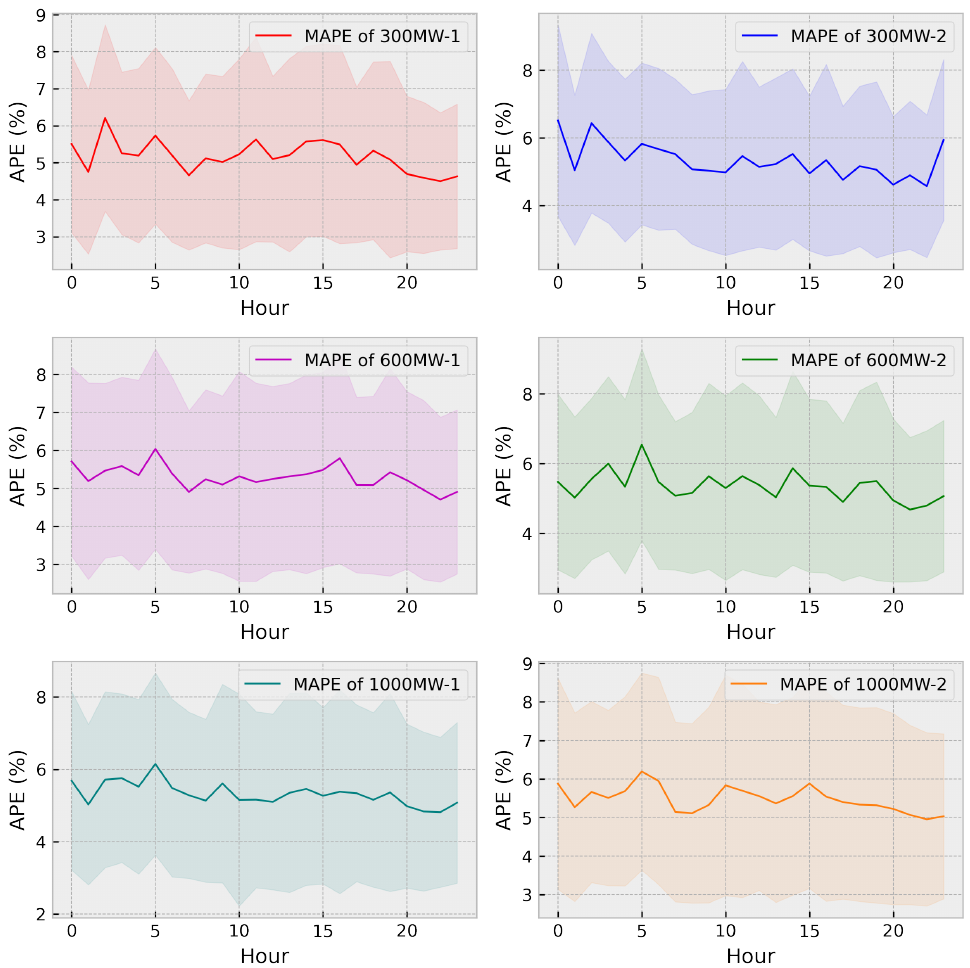
Figure 17. Analysis of the uncertainty of EEN according to estimated hourly CO 2 emissions at different